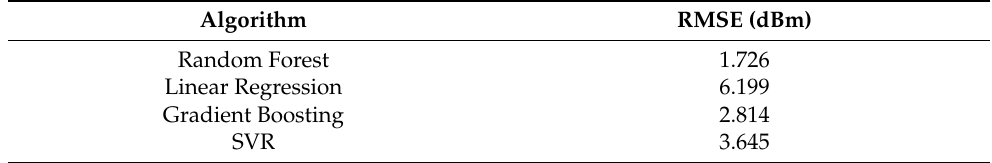
Table 3. RMSEs of four regression